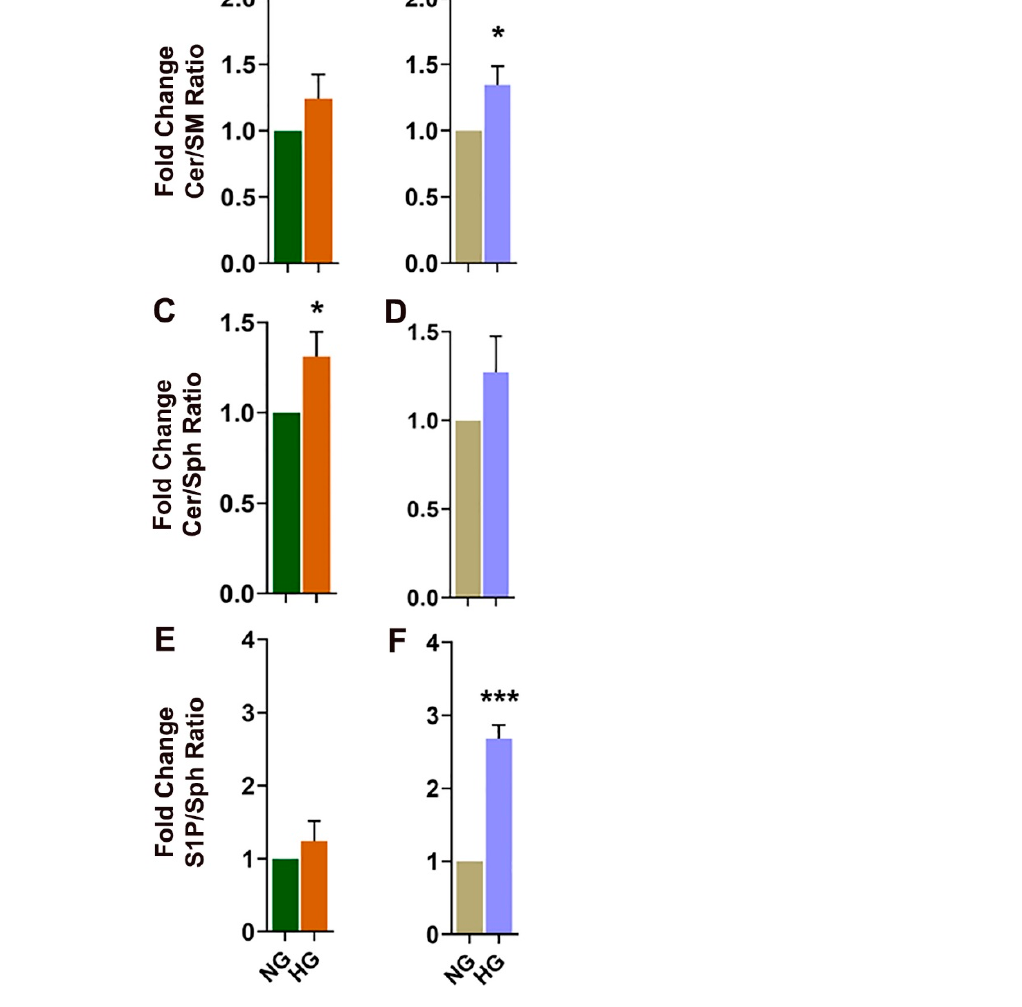
Figure 6. Ratios of major SPL classes in HREC and BV2 cells cultured in 5 mM glucose (NG) or 25 mM glucose (HG) conditions for 48 h. ( A ) Cer:SM, ( C ) Cer:Sph, and ( E ) S1P:Sph ratios in HREC. ( B ) Cer:SM, ( D ) Cer:Sph, and ( F ) S1P:Sph ratios in BV2 cells. * p < 0.05, *** p < 0.001; n = 6.